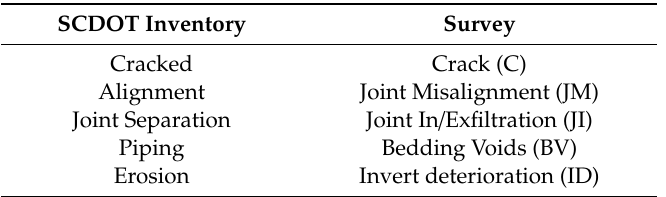
Table 3. Defect mapping for CMP